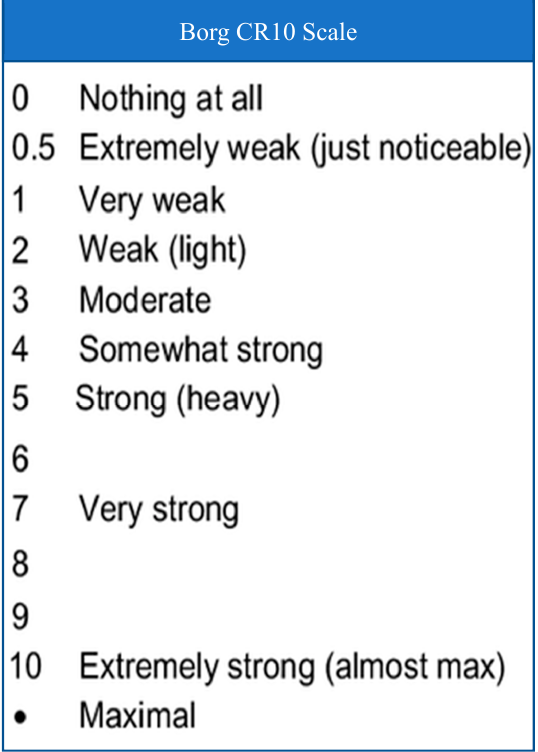
Figure 2. Score of the Borg CR-10 scale used to evaluate the rating of perceived exertion.